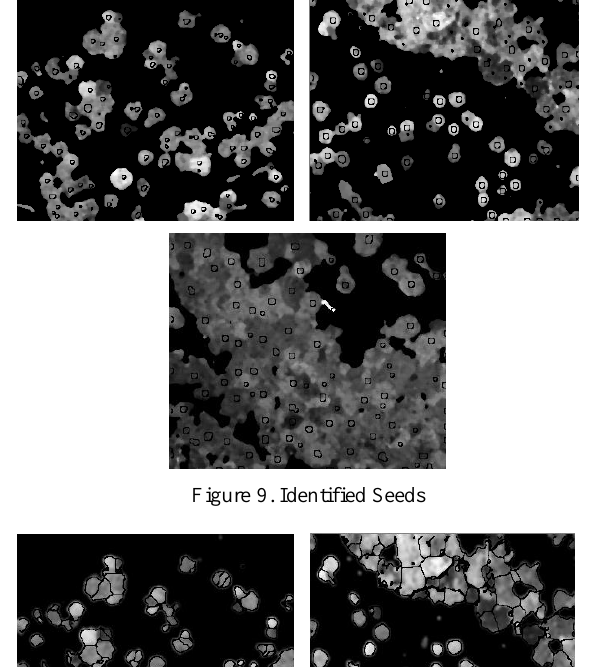
Figure 9. Identified Seeds